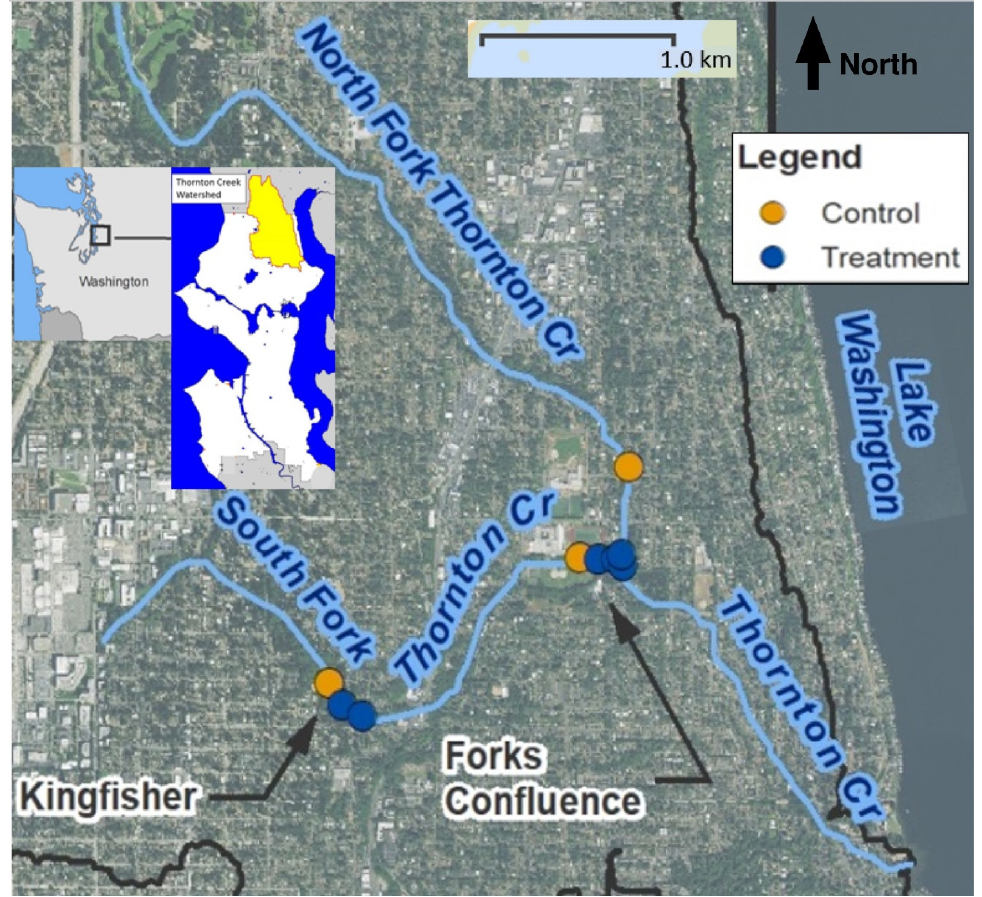
Figure 1. Locations of control and treatment sites for both Seattle Public Utilities (SPU) Thornton Floodplain projects. Right inset shows the watershed (yellow) within the City of Seattle (white). Left inset is a portion of Washington State, USA. Scale shows 1 km = 0.6 mile.